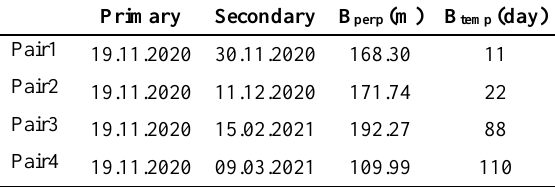
Table 2. Specifications of PAZ pairs.